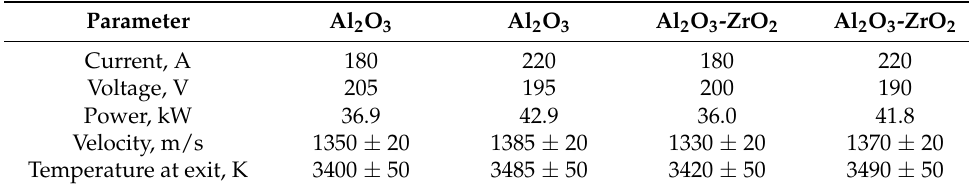
Table 2. Deposition conditions of the